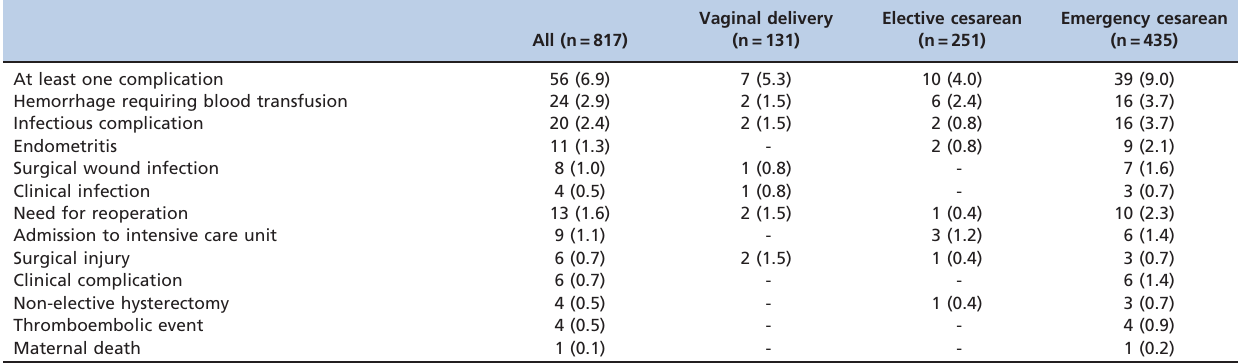
Table 3 - Maternal postpartum complications in twin pregnancies according to mode of delivery. All